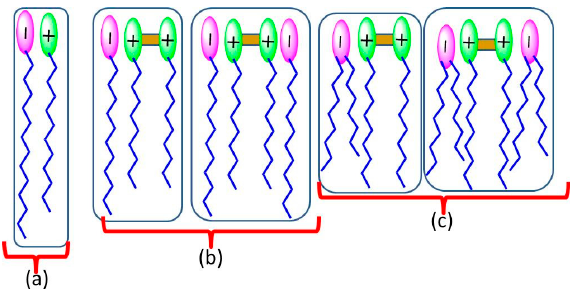
Figure 2. Ion pairs types in the prepared binary mixtures. ( a ) pseudo-dialkyl surfactants in LM systems ( b ) pseudo-trialkyl and tetraalkyl surfactants in C3L mixtures and ( c ) pseudo-tetraalkyl and hexaalkyl surfactants in C3S systems.